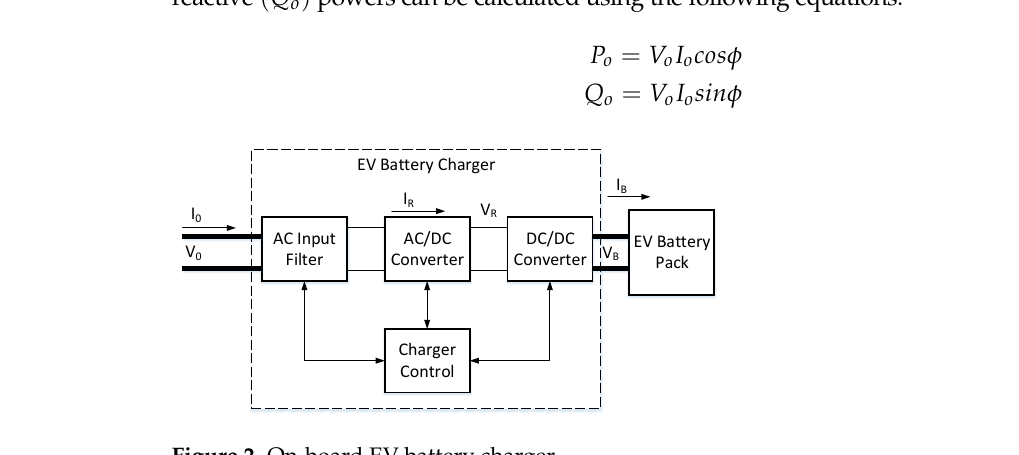
Figure 2. On-board EV battery